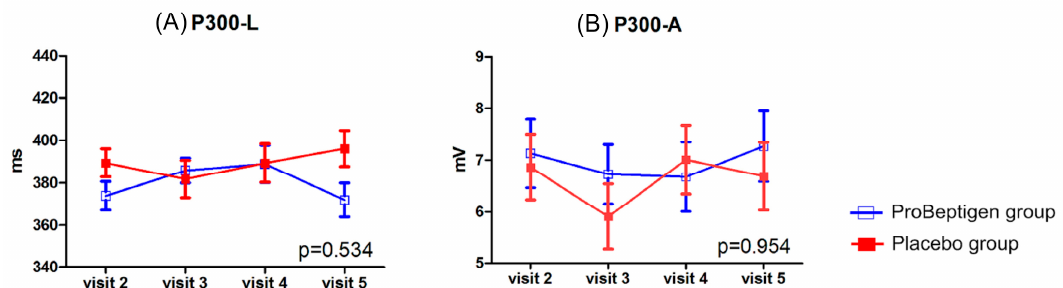
Figure 7. Results of event-related potentials. ( A ) Latency of positive event-related potentials at 300 ms (P300-L), ( B ) Amplitude of positive event-related potentials at 300 ms (P300-A). Error bars represent standard errors. The p -value shown in each diagram denotes the statistics of time × treatment interaction after considering the baseline data as a covariate.